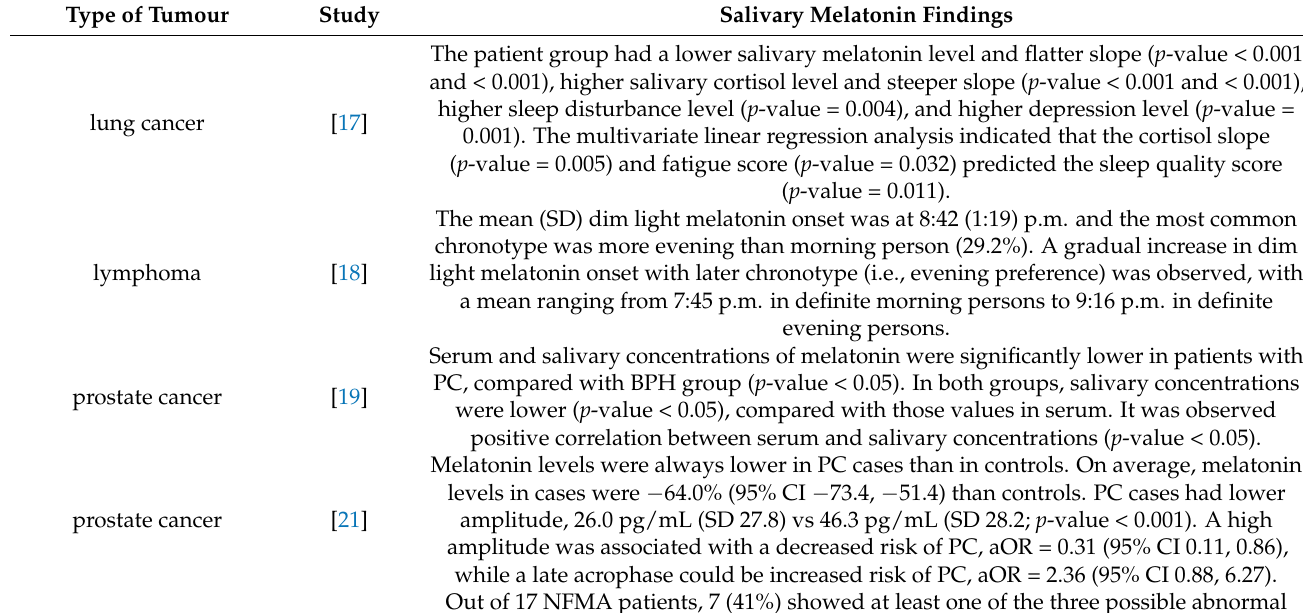
Table 4. The most important findings about salivary melatonin from included studies. Salivary Melatonin